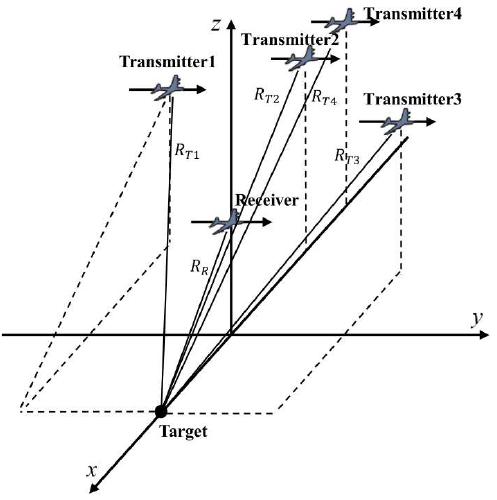
Figure 1. Geometry coordinate system for the position relationship between transmitters, receiver and